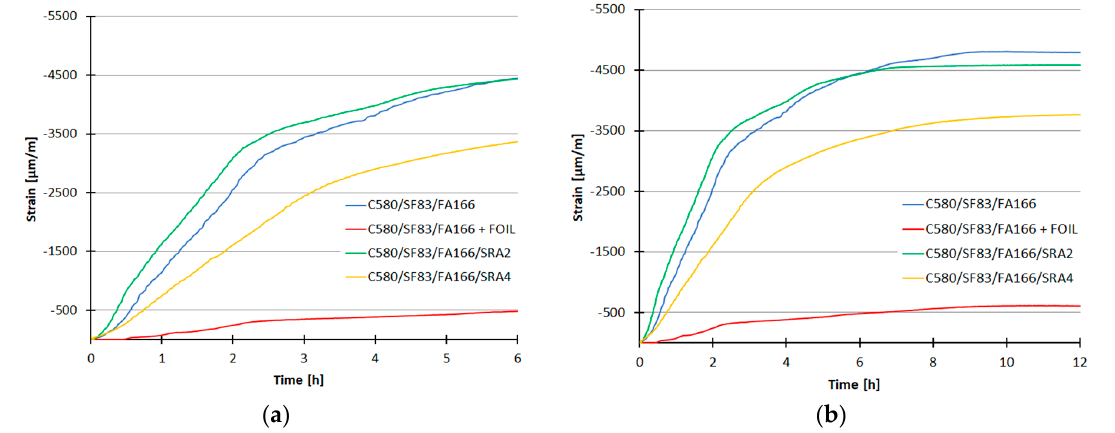
Scheme 6. Average deformation over time: ( a ) 6 h; ( b ) 12 h.